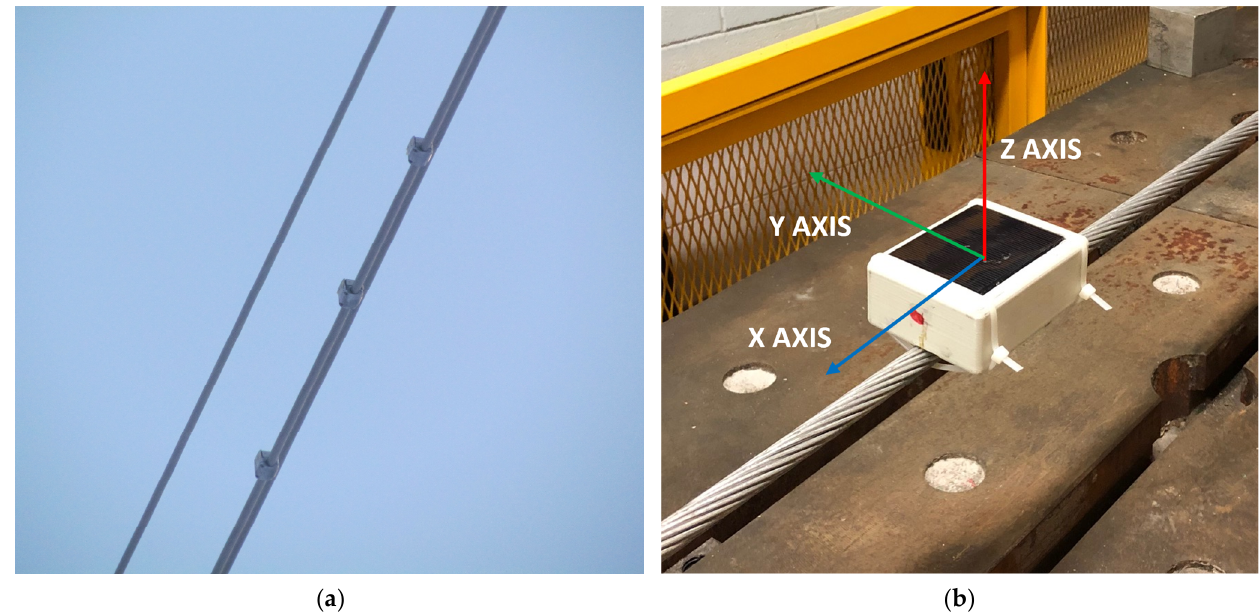
Figure 3. Wireless sensors developed for vibration monitoring of HVTL conductors: ( a ) Three sen- sors mounted on conductors of an operative HVTL; ( b ) Reference system of the triaxial MEMS ac- celerometer equipping wireless sensors.